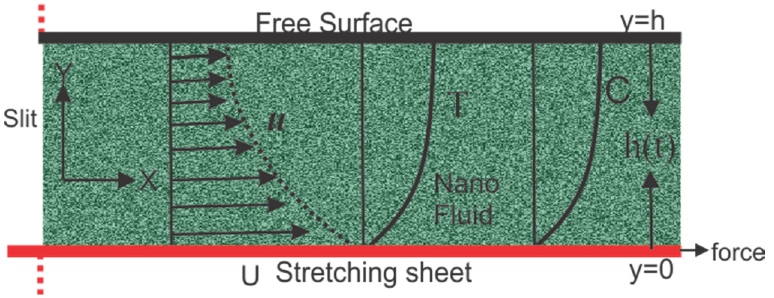
Figure 1. Geometry of the problem